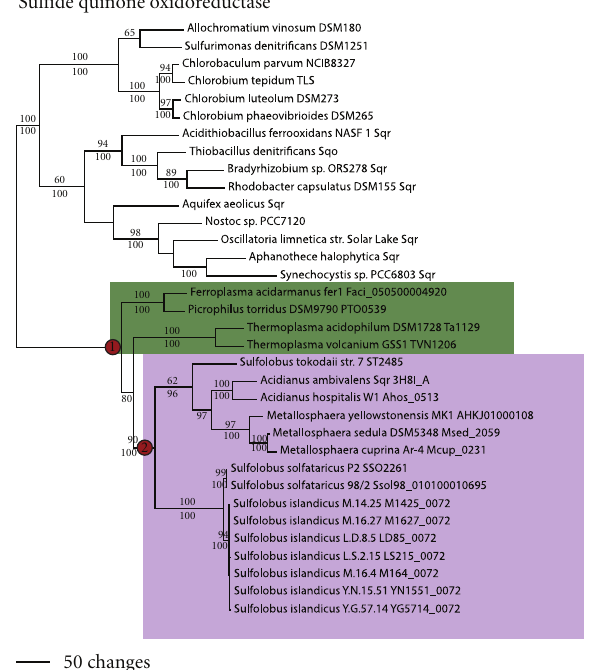
Figure 9: Anaerobic sulfide oxidation. Sulfide quinone oxidoreduc- tase (SQO) phylogeny for (a) Euryarchaeota and (b) Crenarchaeota.